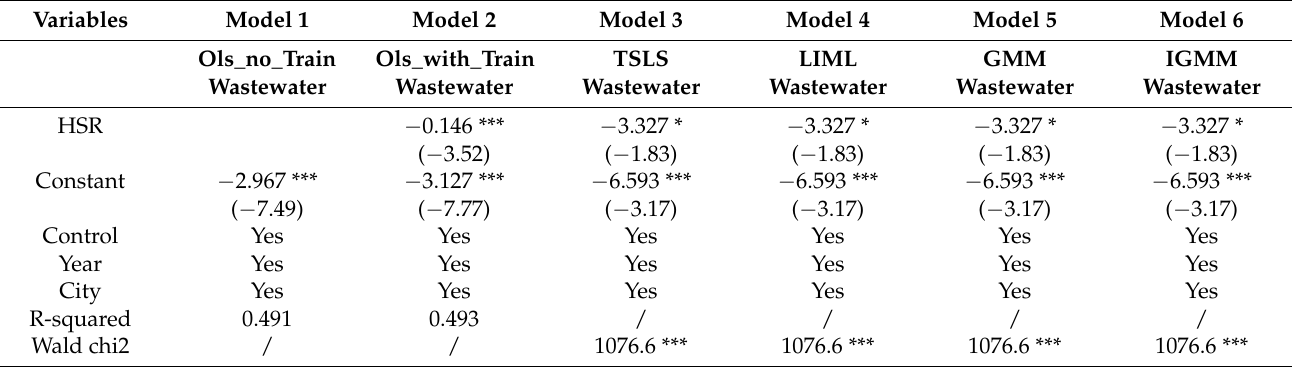
Table 4. Endogenous test results.